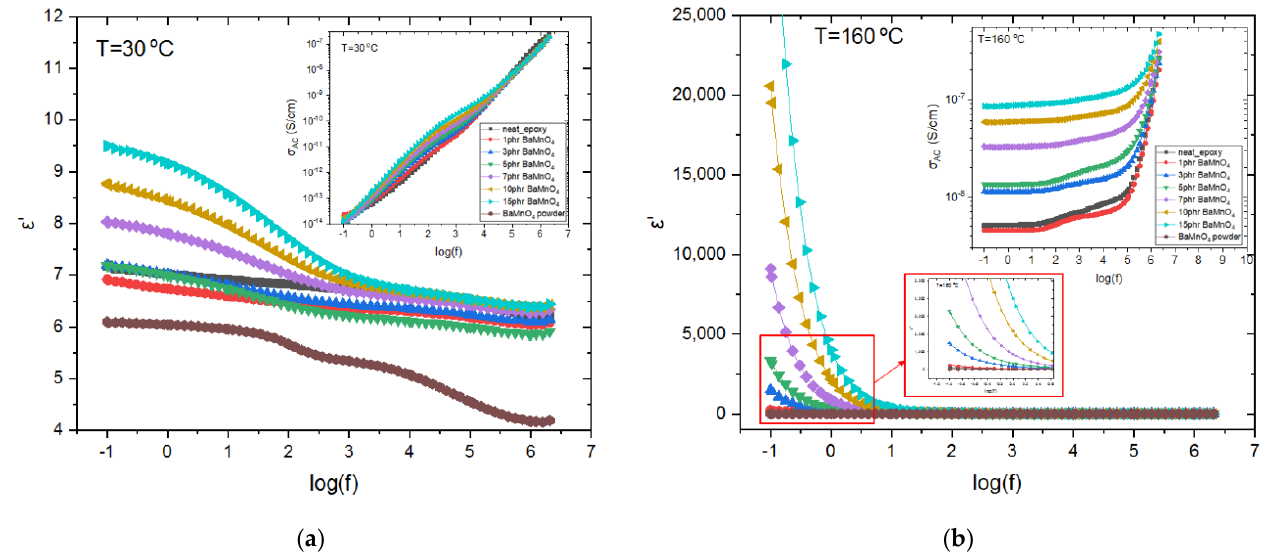
Figure 1. Comparative spectra of the real part of dielectric permittivity as a function of frequency ( a ) at 30 °C and ( b ) at 160 °C for all the specimens under study. Insets depict the AC conductivity as a function of frequency at 30 °C and 160 °C, respectively.